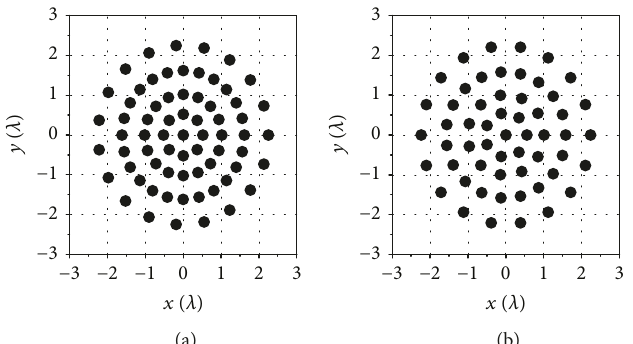
Figure 3: Layouts of the SUACRA 1 and 2: (a) SUACRA 1 (68 elements) and (b) SUACRA 2 (56 elements).